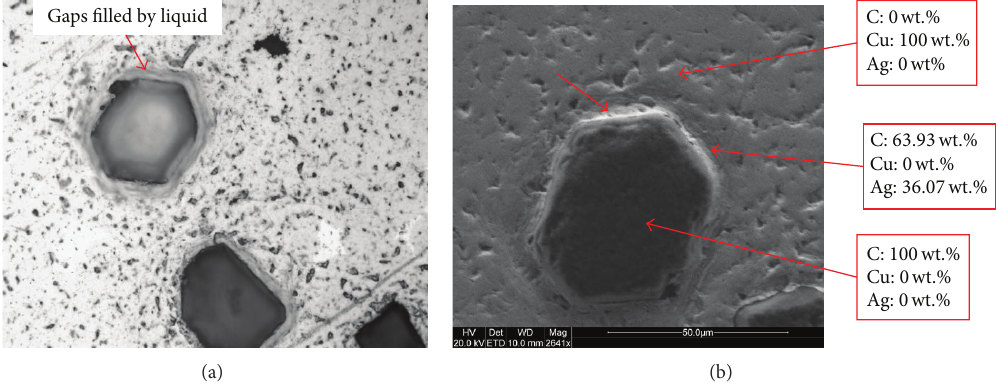
Figure 7: (a) Optical image and (b) SEM image including EDX spot analysis of Cu-10wt.% Ag72Cu-10 vol.% diamond clearly showing the presence of liquid phase at the copper-diamond interface during